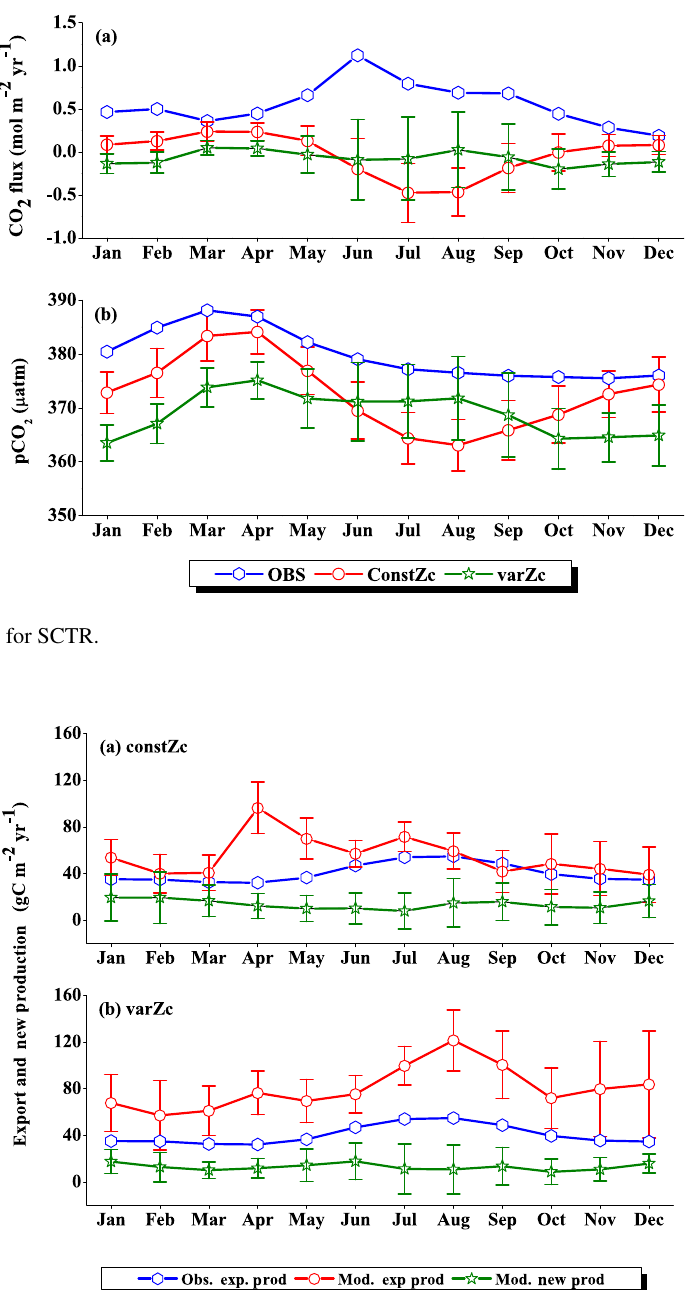
Figure 15. Same as Fig. (7), but for